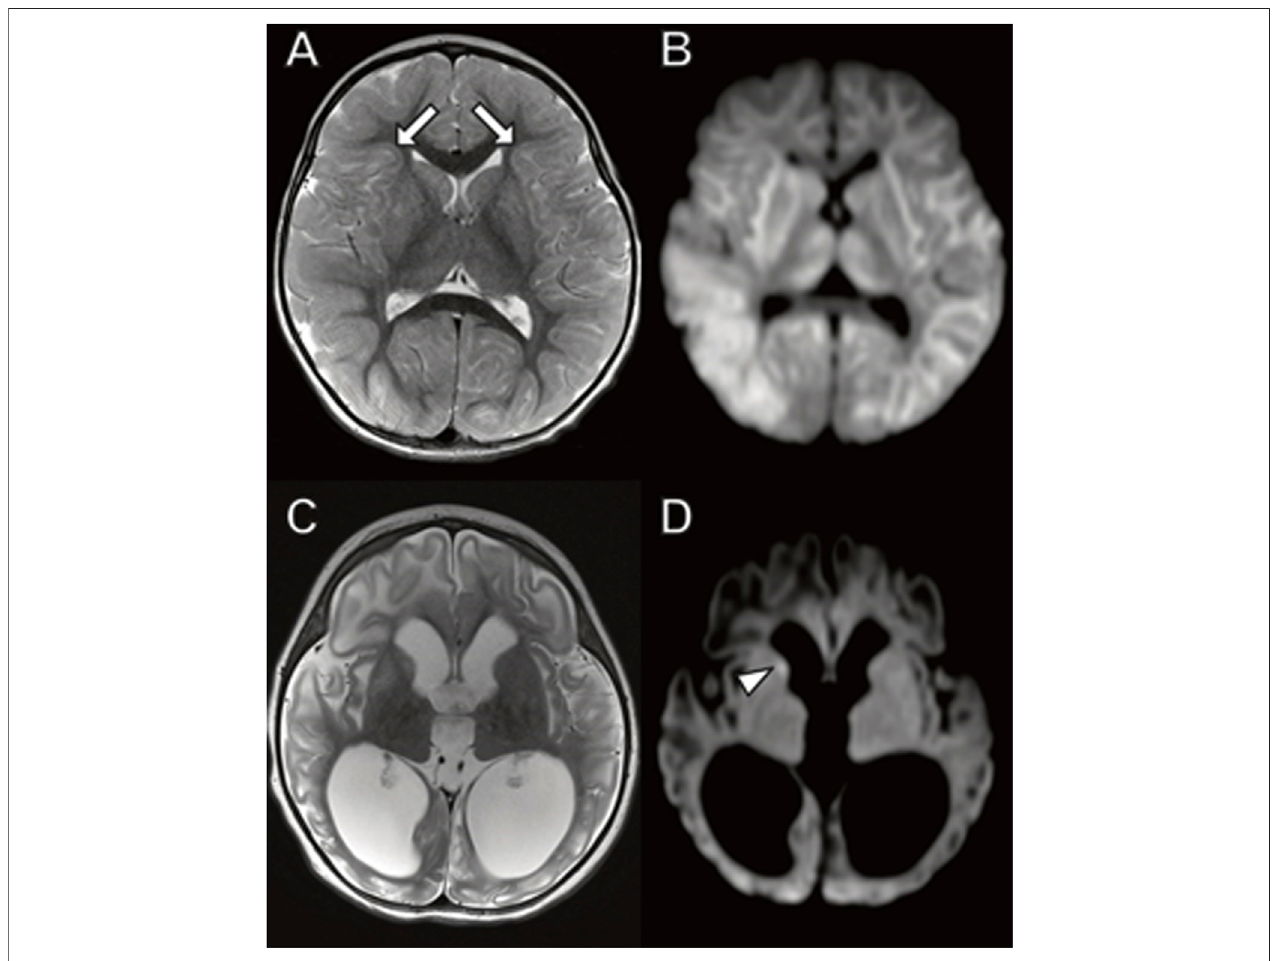
FIGURE 5 | Brain MRI in young girl with TANGO2 mutation. (A,B) Diffusely abnormal brain MRI at 16 months characterized by (A) abnormal hyperintense T2 and (B) diffusion-weighted imagingsignal throughout thewhitematter and basalganglia, including involvementofsubcorticalU fi bers (A, arrows). (C,D) Follow-up brainMRI 2 months later with ventriculomegaly due to atrophy with (C) associated abnormal T2 signal hyperintensity involving cerebral white matter and basal ganglia. (D) Restricted diffusion is largely resolved with small area of persistent diffusion-weighted signal abnormality in the right caudate